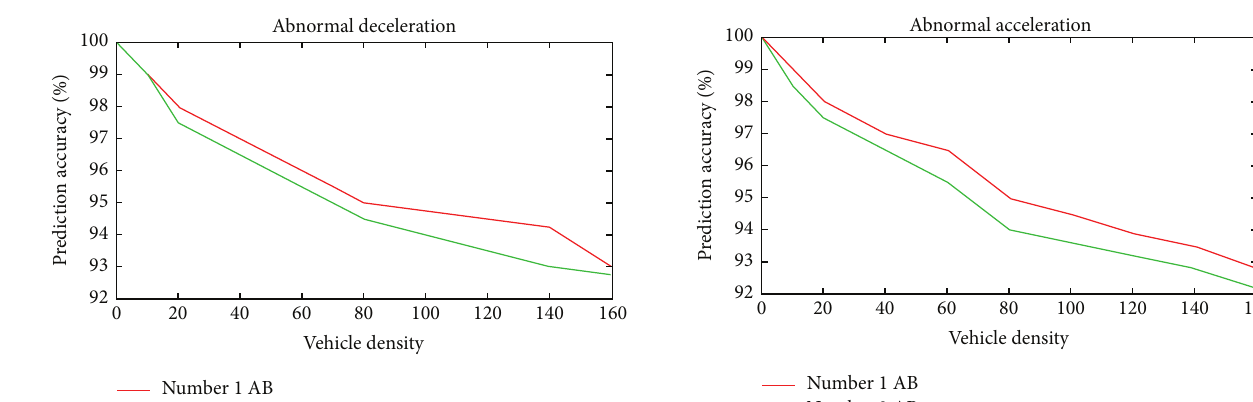
made to change their lanes from inner to outer and outer to inner in different